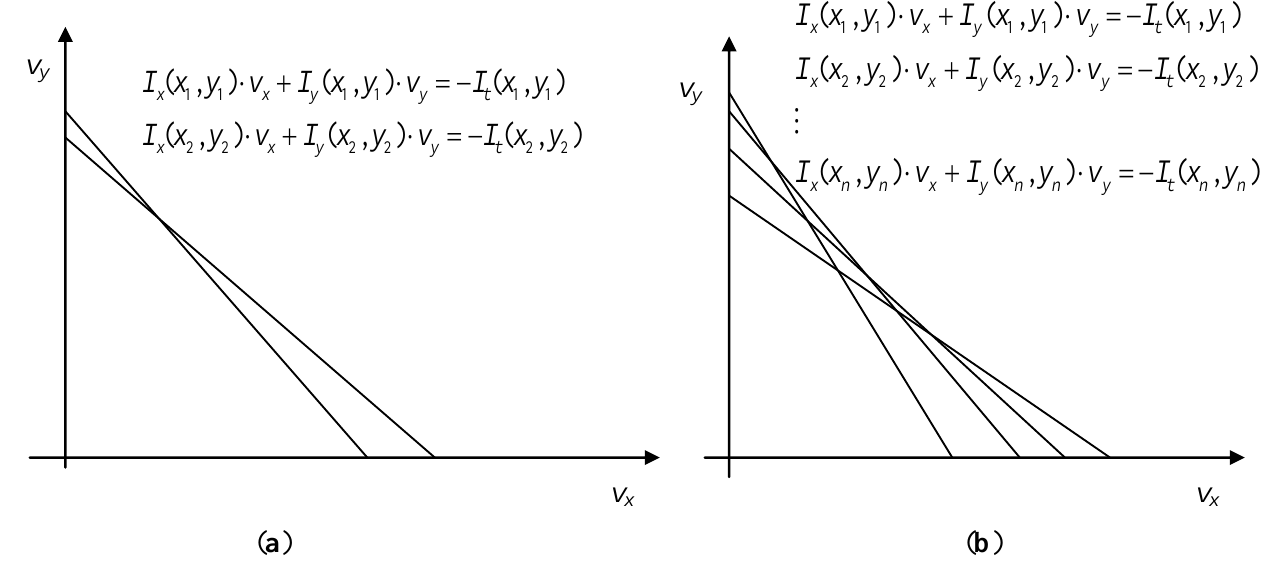
Figure 2. Intersection of ( a ) two optical flow and ( b ) several optical flow constraint